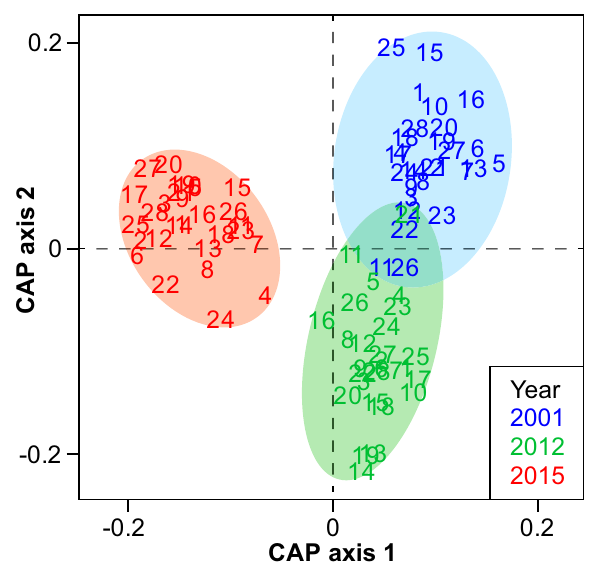
Fig. 4 Results of Canonical Analysis of Principal Coordinates (CAP) comparing the abundances of macrobenthos in the 28 sites among the three surveys conducted in 2001, 2012 and 2015. The analysis was based on fourth-root transformed family abundance data (resemblance: Bray – Curtis similarity; number of permutations = 999). Data from the three surveys diverge signi fi cantly from each other (pairwise tests, P <